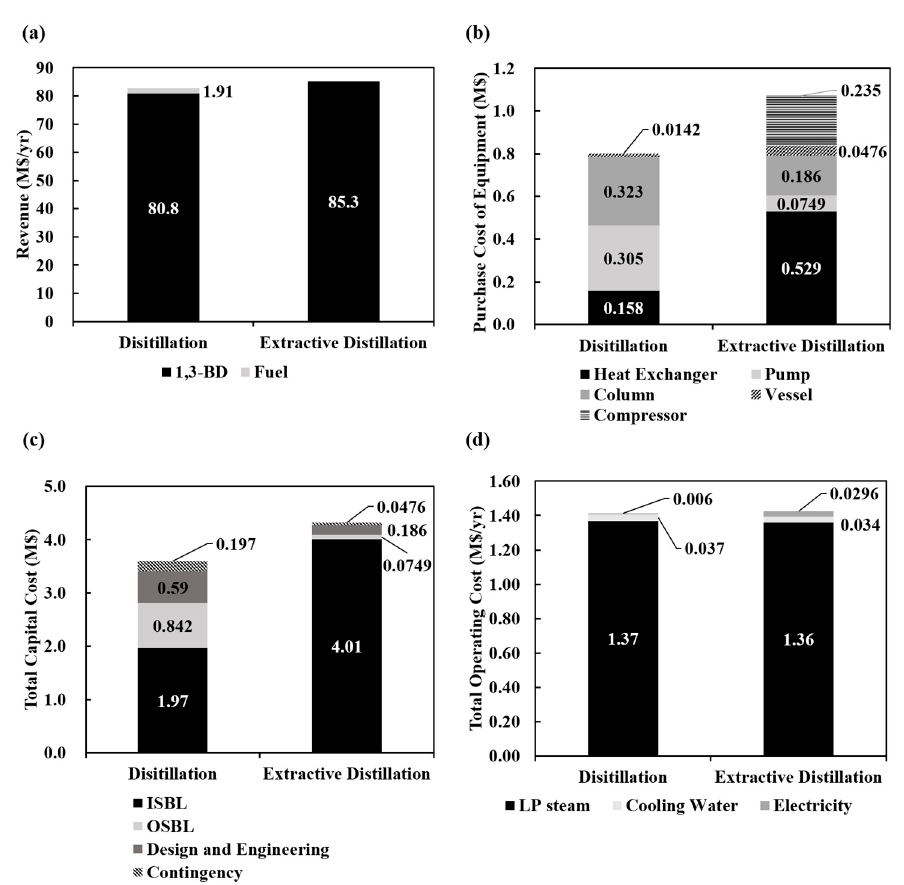
Figure 6. Comparison of the economics of the conventional and extractive distillation processes: ( a ) Revenue; ( b ) purchase cost of equipment; ( c ) total capital cost; and, ( d ) total operating cost [11,19] .